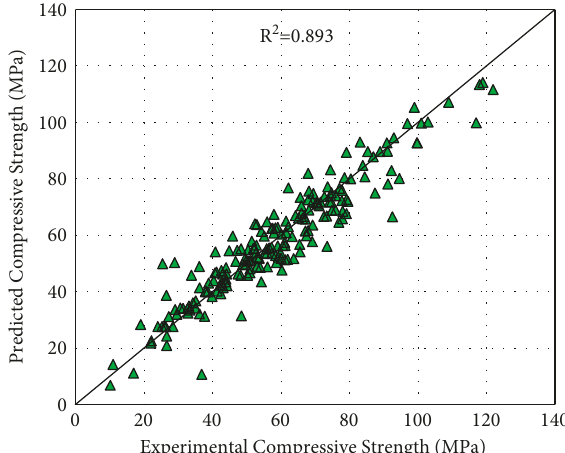
Figure 7: Experimental vs. forecasted compressive strengths for ANN-BAT-1L (14) model for all data.